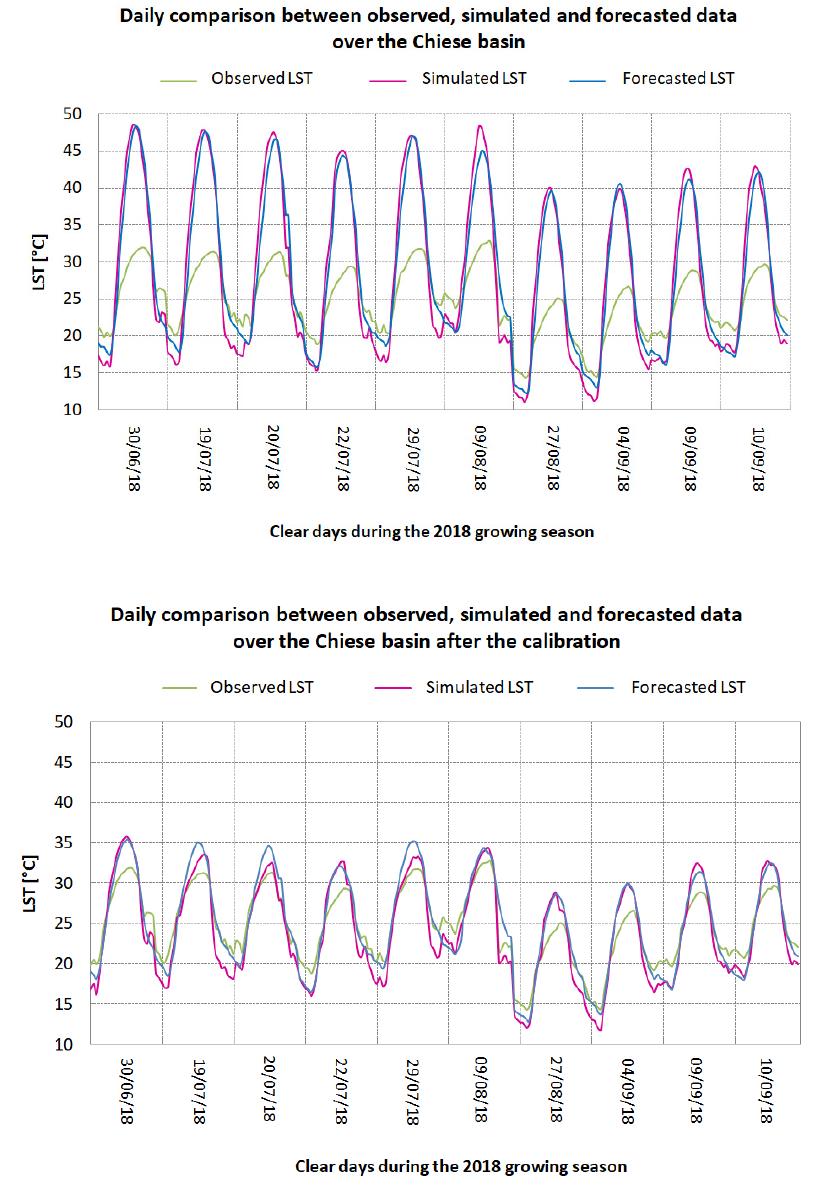
Figure 7. Comparison between observed, simulated and forecasted data over the Chiese basin for ten non-consecutive days during the 2018 growing season before ( top ) and after ( bottom ) the calibration.